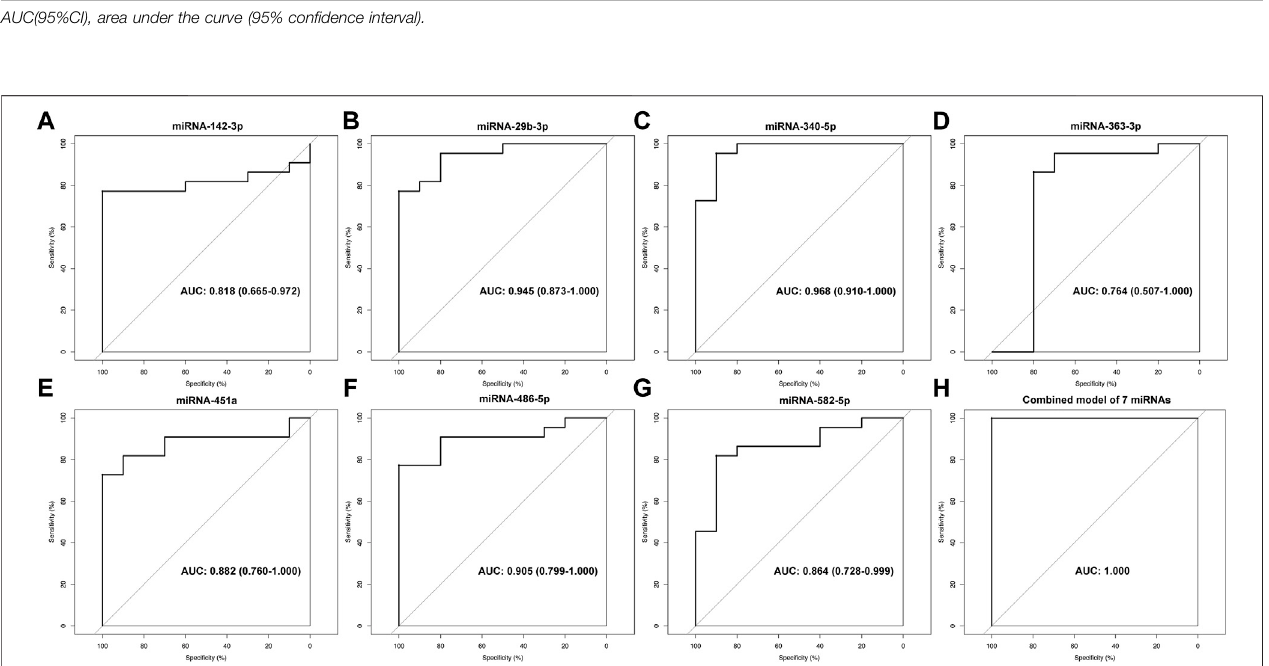
Frontiers in Genetics |